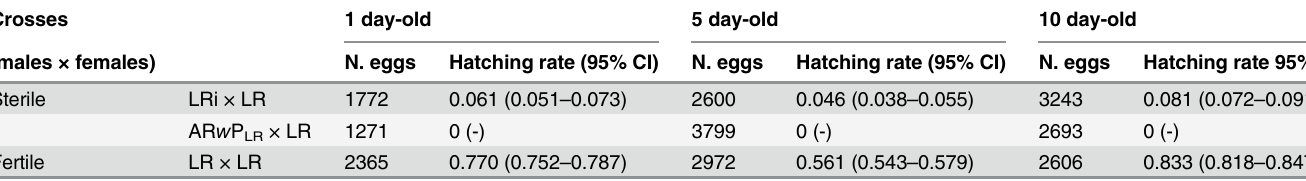
Table 2. Sterilizing capacity of irradiated and incompatible males. Crosses 1 day-old (males ×